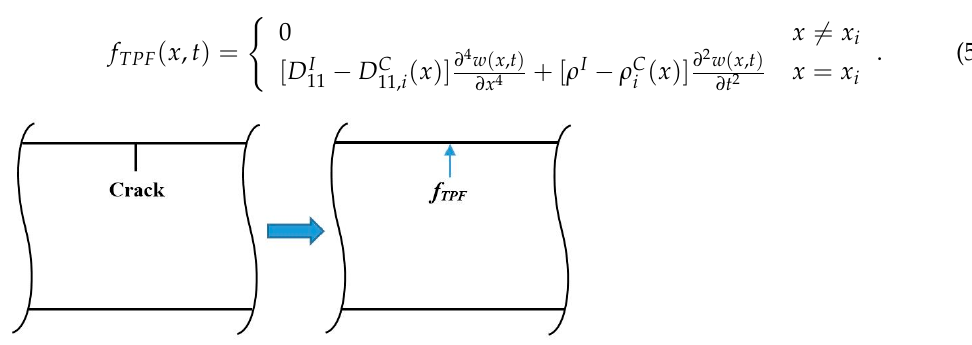
Figure 1. Sketch of crack-induced TPF.